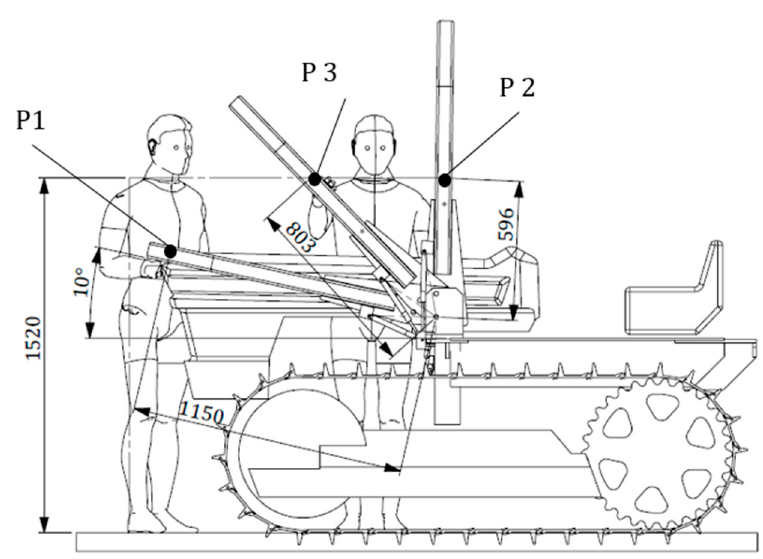
Figure 7. Positions of the grasping points to handle the FROPS (measures are expressed in mm).